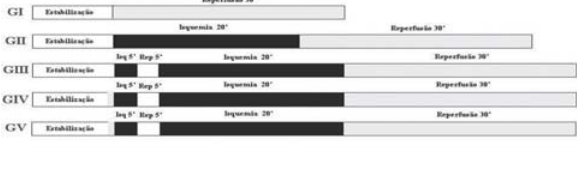
Fig. 2 - Esquema dos protocolos de perfusão com respectivas ações temporais. Isq - isquemia, Rep - reperfusão